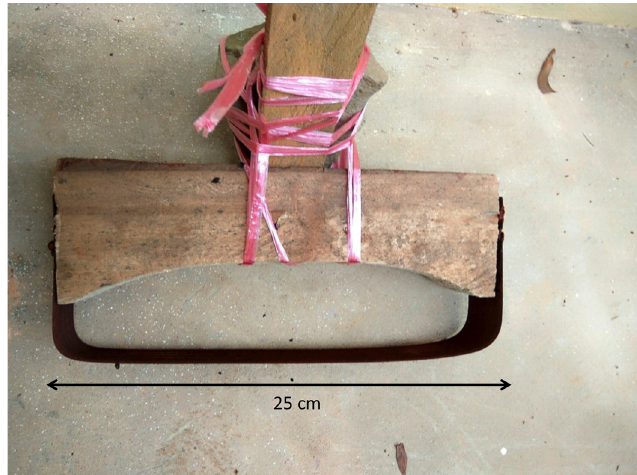
Fig. 2. The artisanal hand dredge “ kerek ” with blade measurement of 25 (cid:1) 5 cm 2 and a penetration below sand surface of about 15